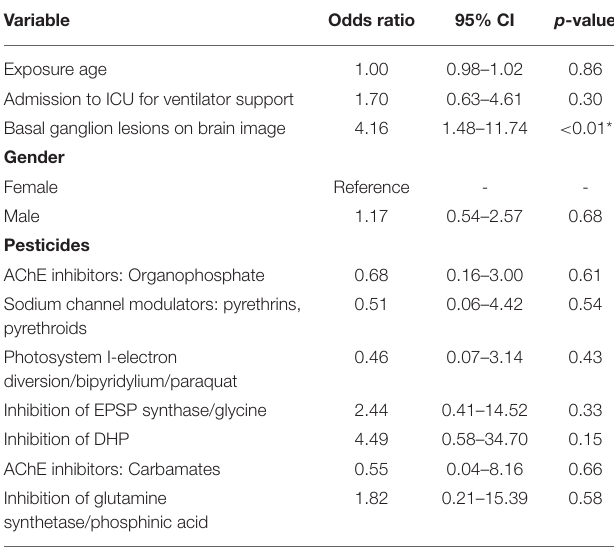
TABLE 2 | Multiple logistic regression analysis of risk factors associated with neurological